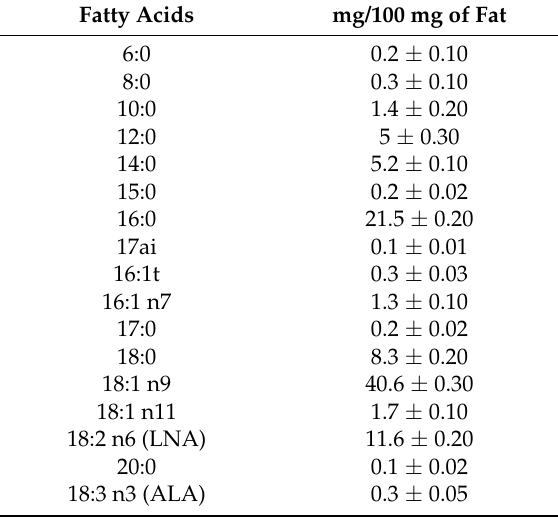
Table 1. The fatty acid composition of the pooled human milk used in this experiment. Fatty